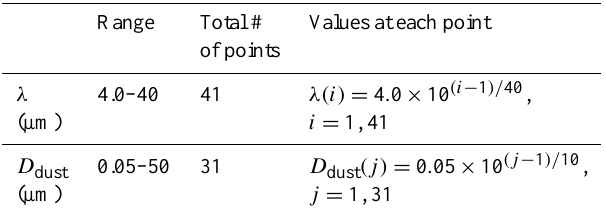
Table 2. The range of each dependent variable dimension, the total number of points in each dimension, and the values at each point for long-wave aerosol optical property look-up tables for dust